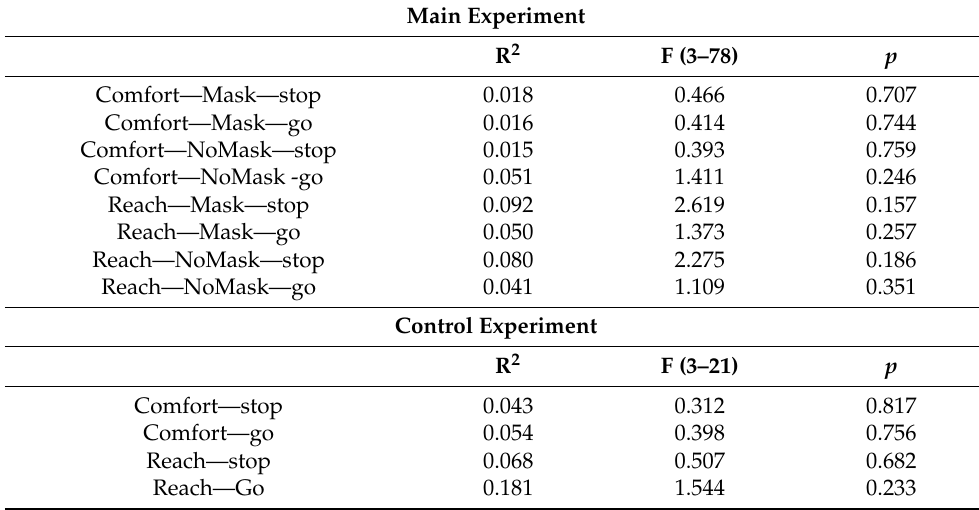
Table 2. Multiple regression with sex, height, and COVID-19 as predictors of subject